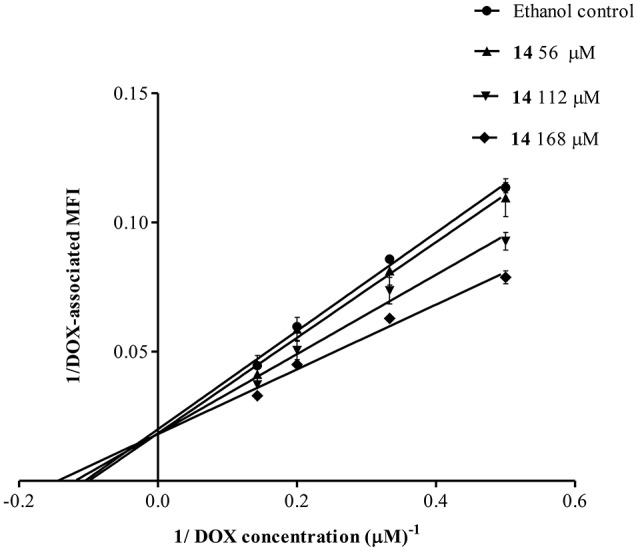
Lineweaver-Burk double reciprocal plot for the kinetic analysis of pinoresinol (14). Lucena 1 cells were cultured for 1 h with a series of concentrations of 14 before 1 h exposure to DOX. The lines were drawn using linear least squares fit. Values are expressed as mean ± SE.